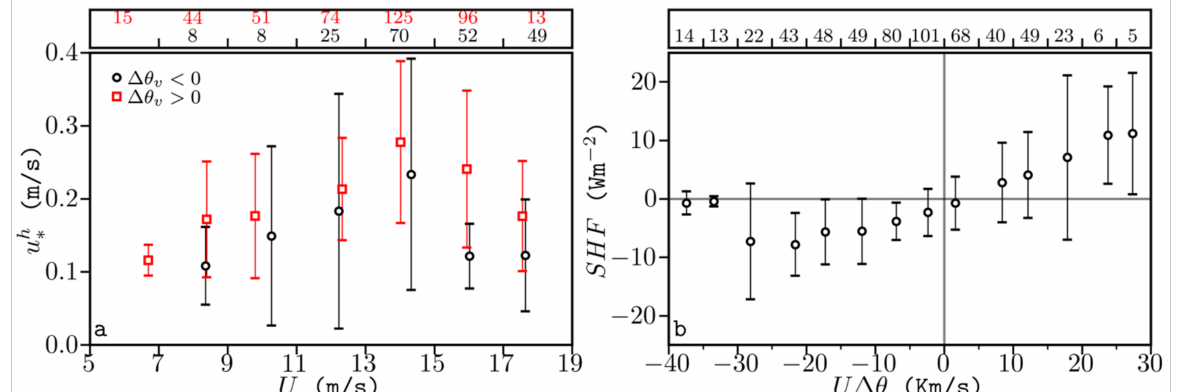
Figure 5. ( a ) Median and median absolute deviation of measured u h ∗ as a function of wind velocity (in bins of 2 m/s). The black circles and red squares refer to samples with negative and positive potential virtual temperature differences between the sea surface and the air, ∆ θ v = θ v ( sea ) – θ v ( air ) . The number of samples (>5) per bin is shown over the plot. ( b ) Median and median absolute deviation of measured SHF as a function of U ∆ θ , the product of wind velocity, U , and potential temperature difference, ∆ θ = θ ( sea ) – θ ( air ) (in bins of 5 Km/s).